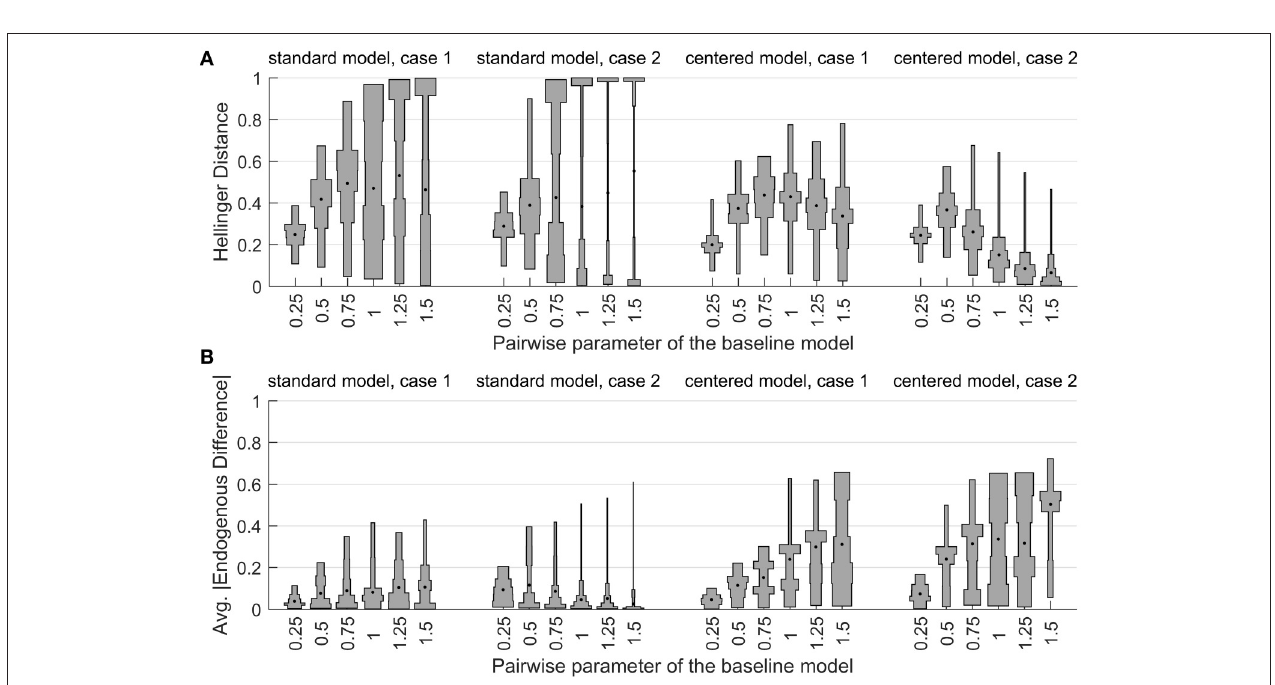
FIGURE 10 | The distribution of (A) Hellinger distance to the baseline model and (B) average absolute difference in endogenous probability vs. the baseline model, for the minimum-distance models in the network example.